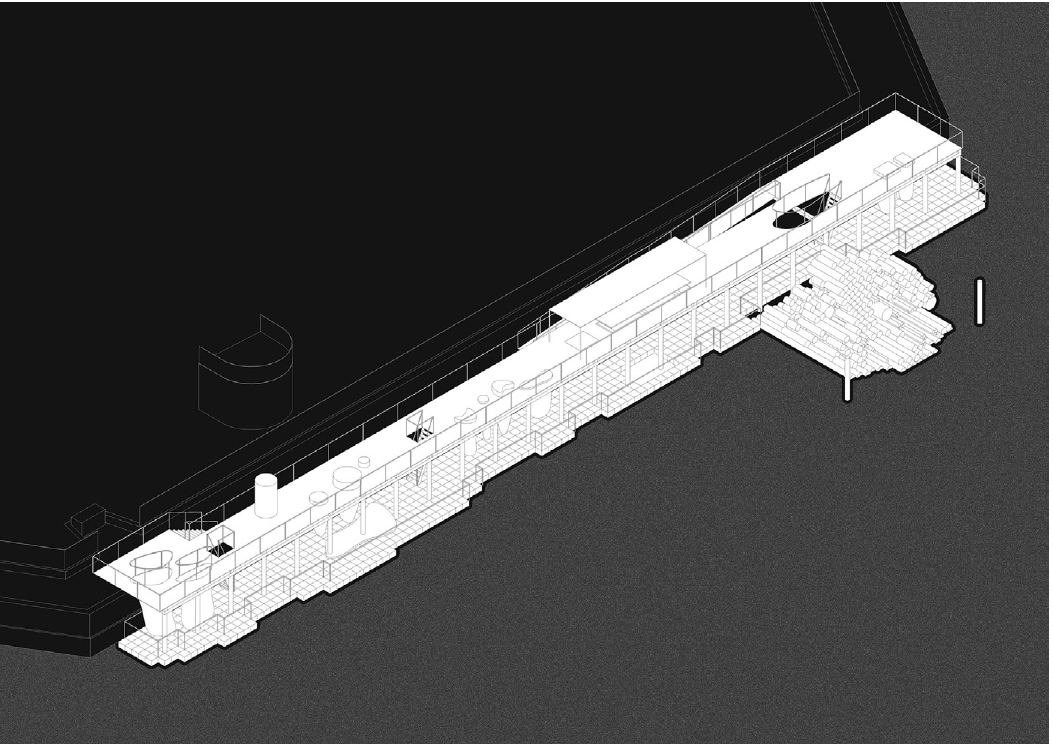
Figure 10. Axonometric view based on unrealized proposal for the “Swamp Pavilion” curated by Nomeda & Gediminas Urbonas for Lithuanian representation at 16 th International Architecture Exhibition